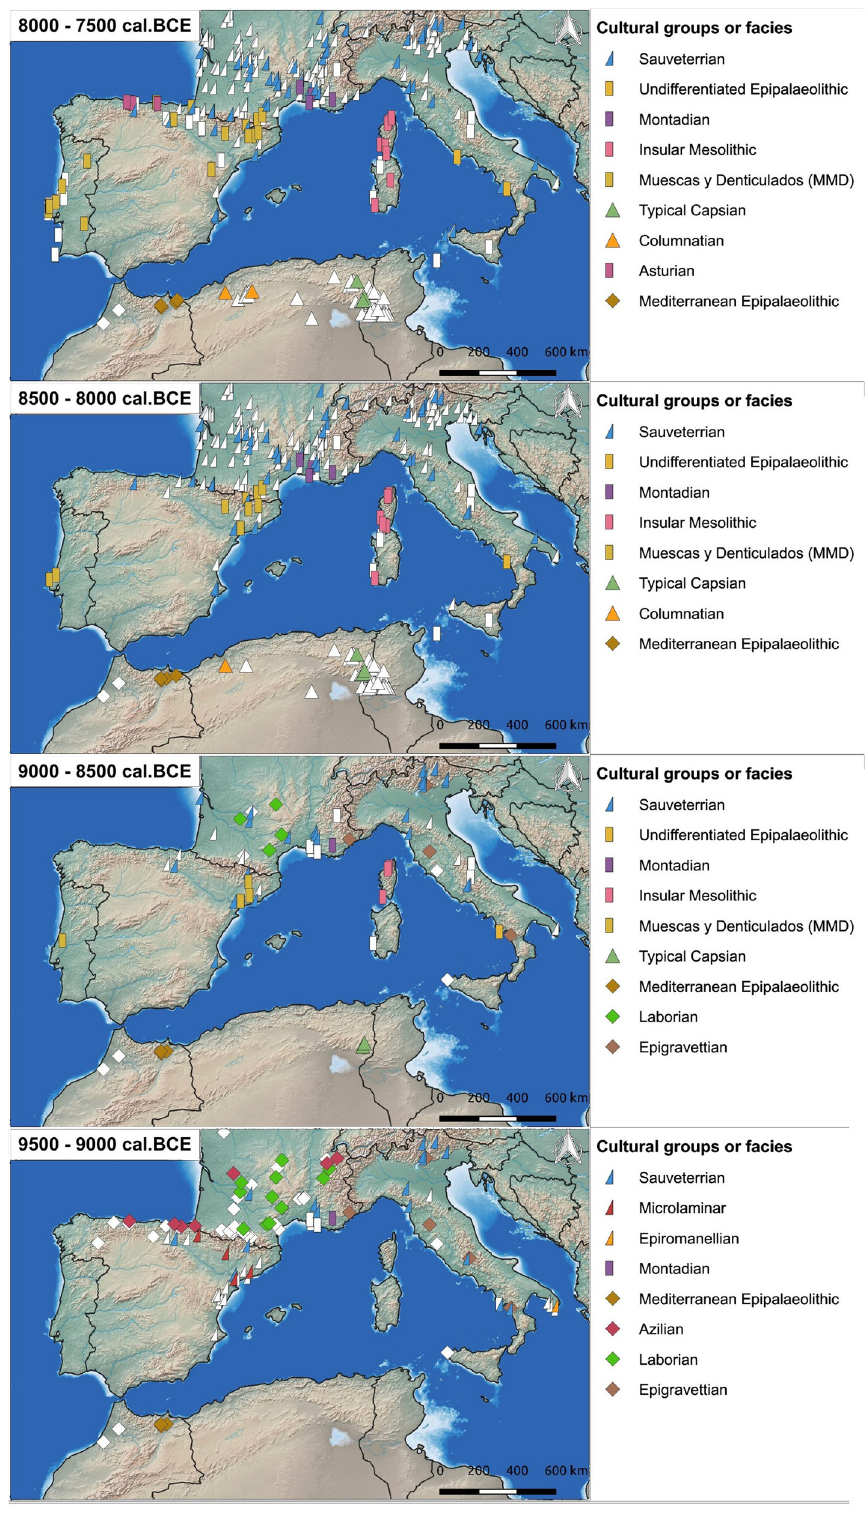
Figure 3: Chronological maps of First Mesolithic sites in the western Mediterranean in 500 - year increments, between 9500 and 5500 cal. BCE according the last calibration curve ( Reimer et al., 2020 ) . The coloured dots represent the dated occupations while the white symbols are not directly dated ones ( these occupations are only relatively dated, mainly on a chronotypological basis ) . All the data used in this map are freely readable in the BDA database ( https://bda.huma - num.fr/ )